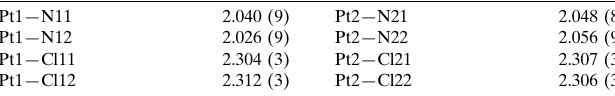
Selected bond lengths (A˚ ).